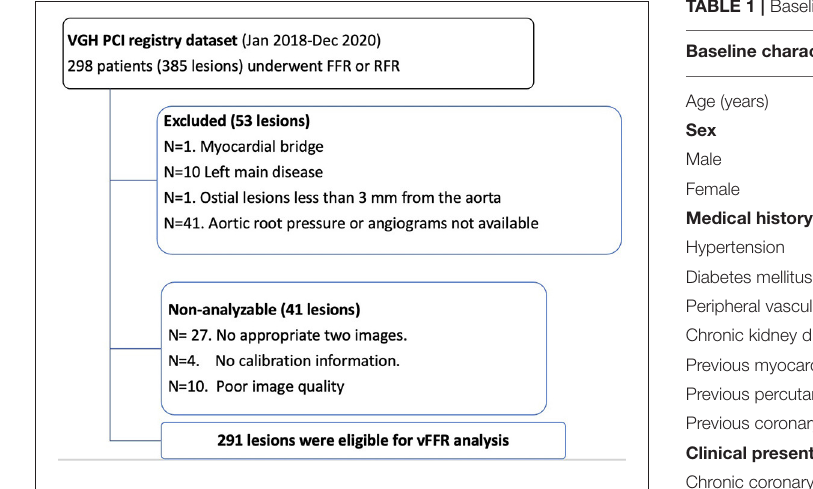
FIGURE 2 | Study flow.